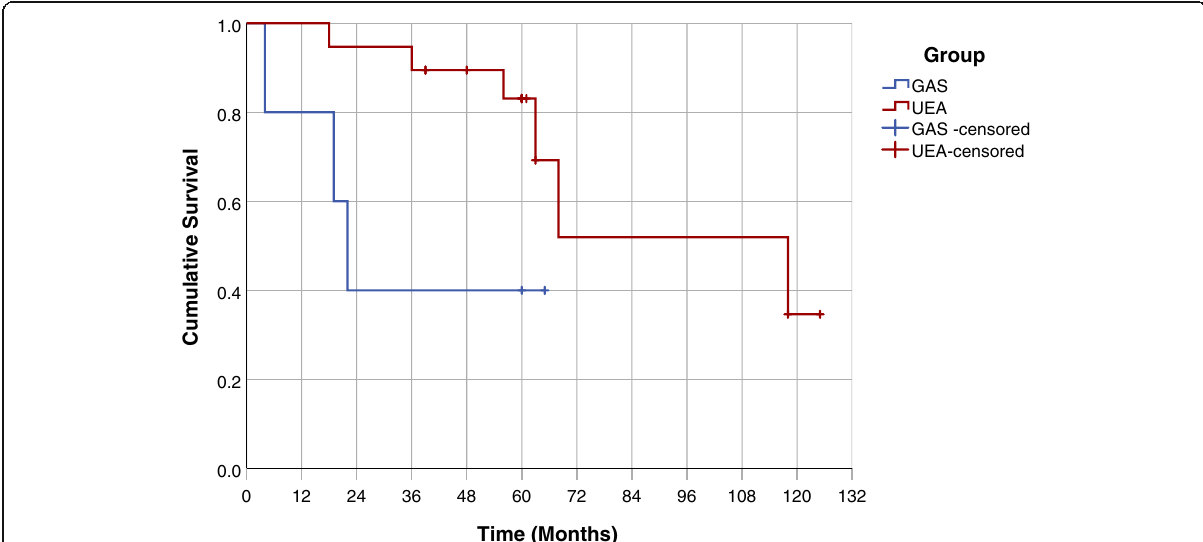
Fig. 4 Kaplan-Meier Curve of the time to death in months among the GAS and UEA patients. Test of equality of the survival distributions was assessed using the Log Rank test ( p =